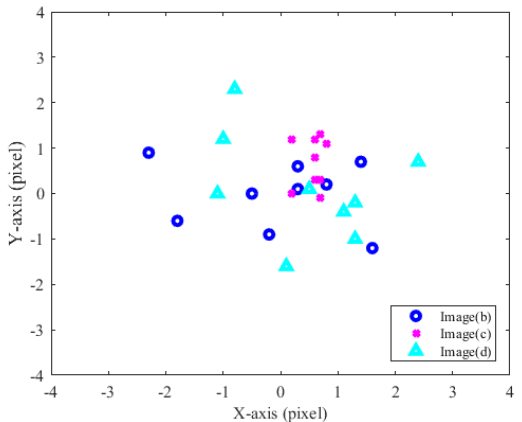
Figure 6. The integer-pixel matching error corresponding to different scale images.